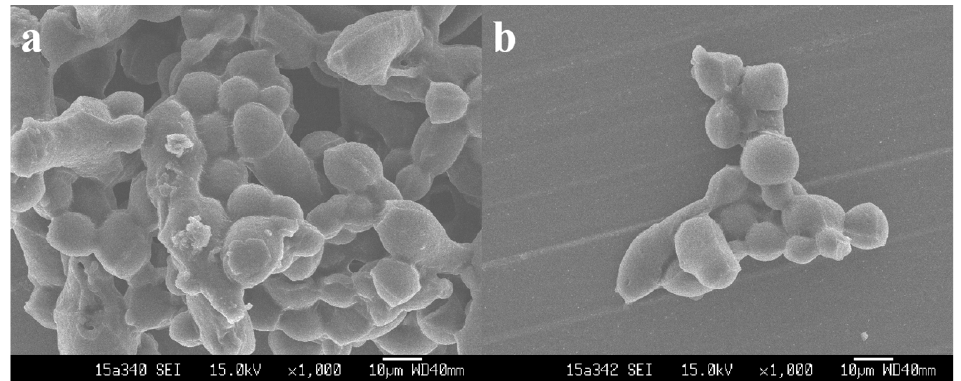
Figure 7. Scanning electron microscopy (SEM) of the microencapsulated OMC. ( a ) Structure of microcapsule aggregates, ( b ) structure of several microcapsules connected together. microcapsule aggregates, ( b ) structure of several microcapsules connected